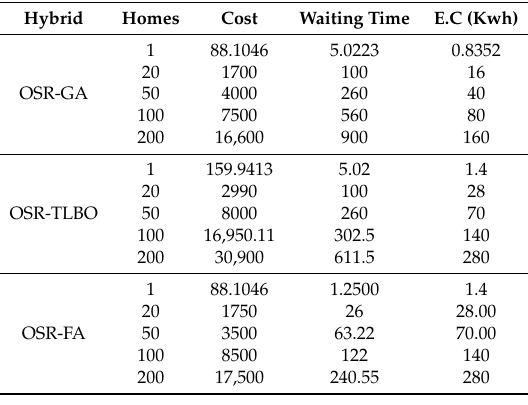
Table 10. Dishwasher Simulation Statistics.